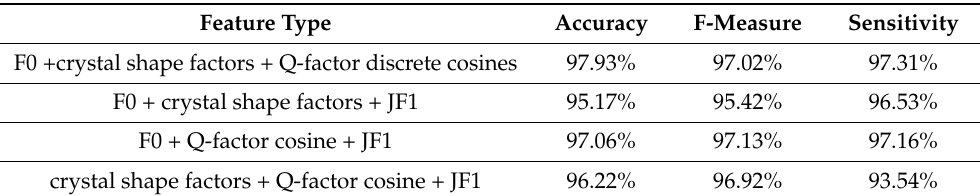
Table 11. Model Joining: Triple Feature Groups for DAE with Fine Tuning.